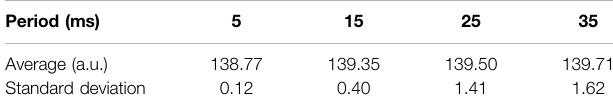
TABLE 4 | Driving effect comparison when different period pulse waveforms were used to drive